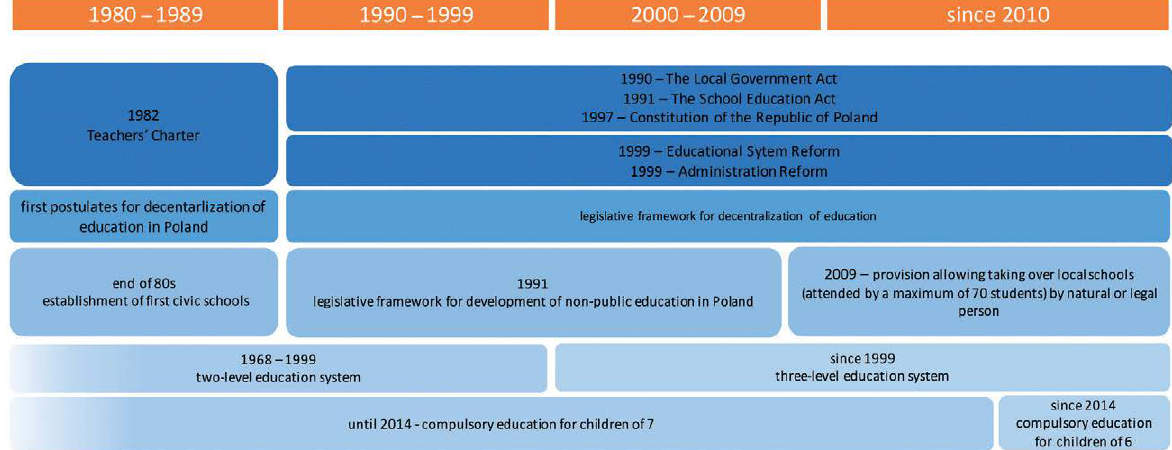
Fig. 2. Evolution of the educational system in Poland. Source: own